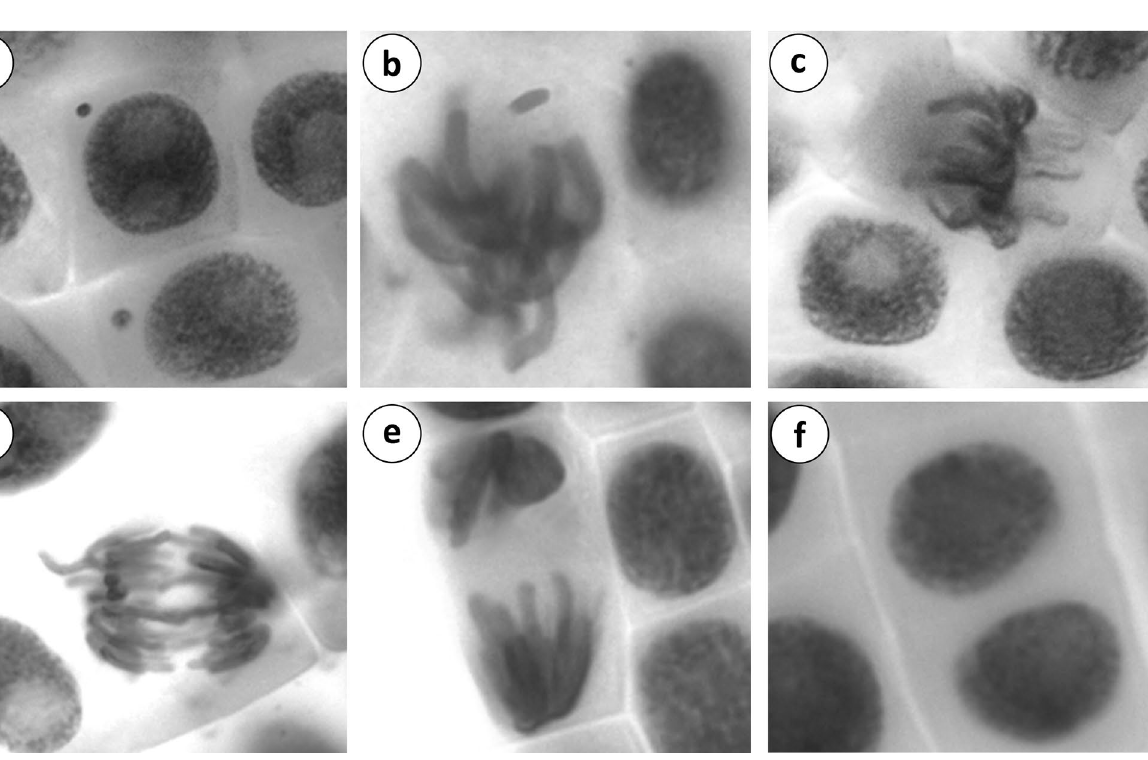
Figure 2. CAs and MN formations induced by pendimethalin ( a : MN, b : fragment, c : sticky chromosome, d : bridge and vagrant chromosome, e : unequal distribution of chromatin, f : binucleated Effect of pendimethalin on lipid peroxidation and antioxidant enzymes and protective role of curcumin. MDA level is an important indicator of lipid peroxidation. MDA levels in group I, group II and group III was not statistically significant and were recorded as 5.75, 5.83 and 5.86 µmol/g FW respectively. However, the application of pendimethalin (group IV) increased MDA level (28.75 µmol/g FW). The applica- tion of curcumin along with pendimethalin in group V and VI recovered MDA levels as 19.36 and 17.25 µmol/g FW respectively. A significant difference in MDA level was observed among group IV, group V and group VI (Fig. 4a). The antioxidant enzymes activities mitigate and repair ROS damage in plants. GR maintains the level of reduced glutathione in the cell. The reduced form of glutathione plays important role in the control of ROS. GR levels in group I, group II and group III was insignificant and noted as 55.16, 54.45 and 53.75 µmol NADPH/g FW respectively. GR levels in group IV, group V and group VI were significantly different from the above groups and recorded as 18.15, 22.48 and 28.56 µmol NADPH/g FW respectively (Fig. 4b).